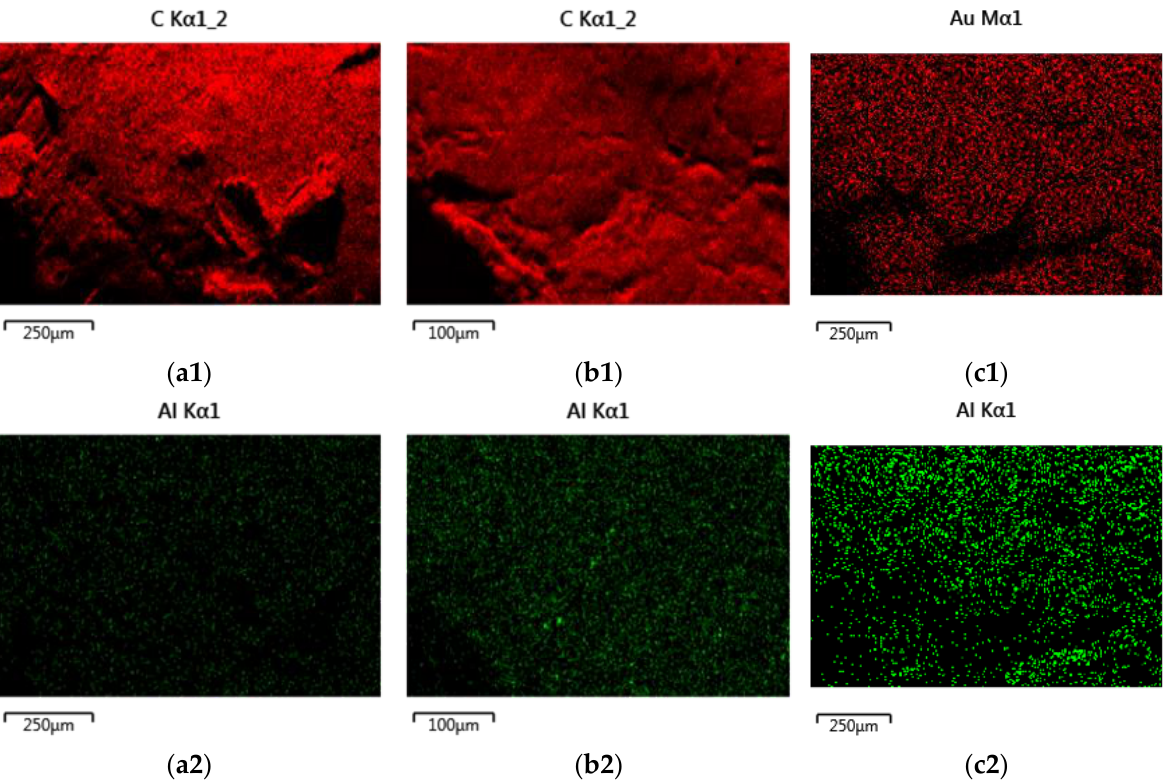
Figure 5. EDX images of the paraffin wax/MWCNT composites: ( a1 , a2 ) PW-1 CNT, ( b1 , b2 ) PW-2 CNT, and ( c1 , c2 ) PW-3 CNT.